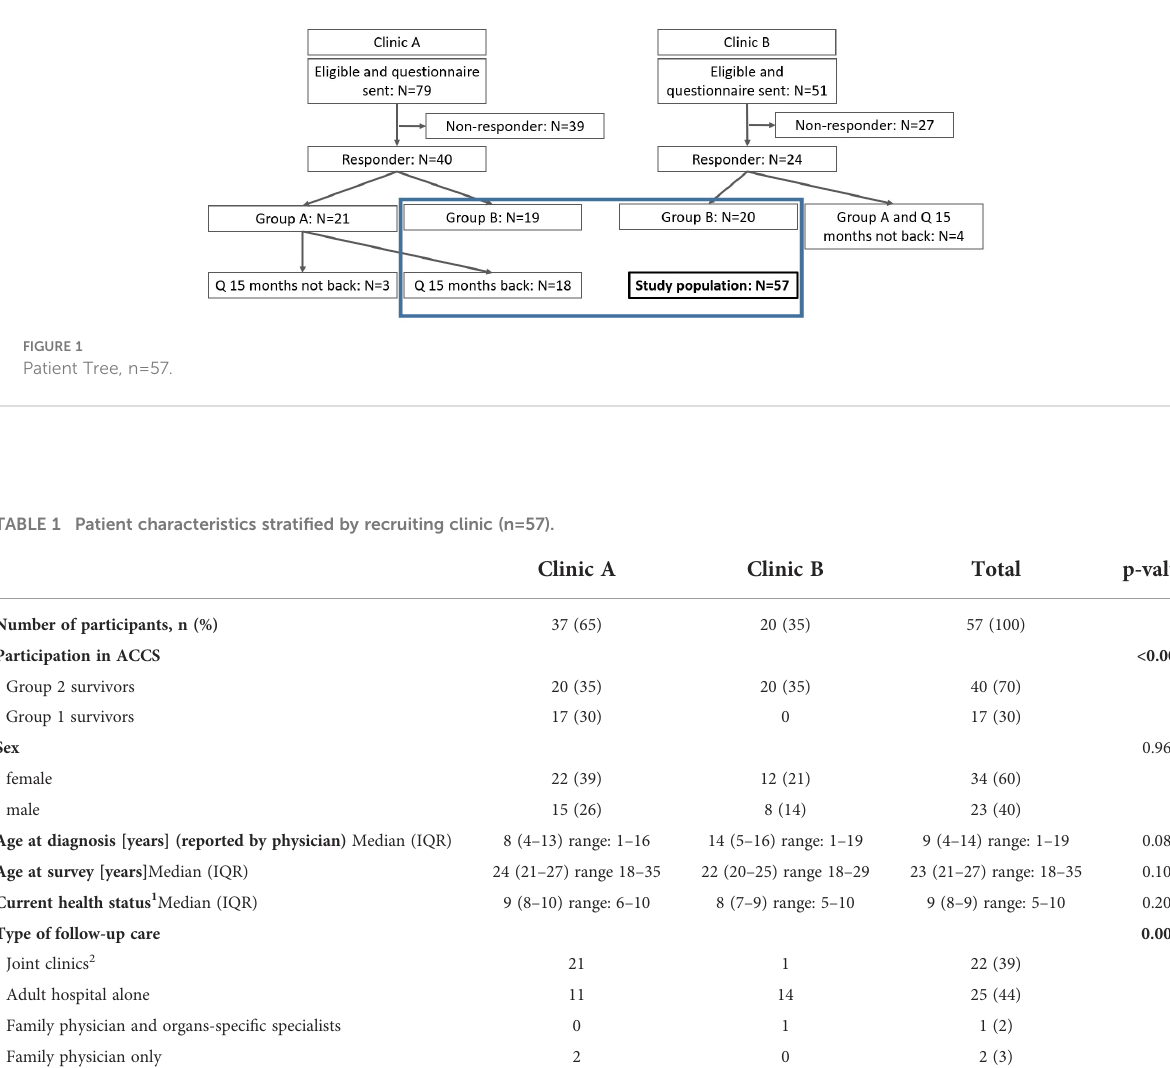
FIGURE 1 Patient Tree,